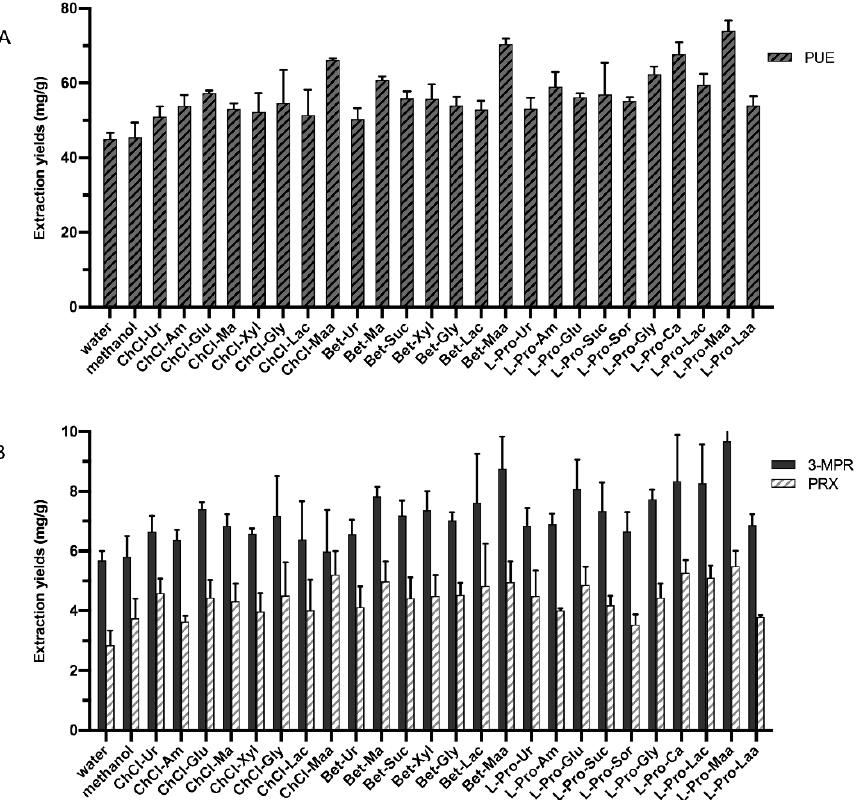
Figure 2. Extraction yields of puerarin (PUE), 3′-methoxypuerarin (3-MPR), and puerarin-6′′-O- xyloside (PRX) from Radix Pueraria (RP) using water, methanol, and 25 different natural deep eutectic solvents (NaDESs). ( A ) Extraction yields of PUE in different solvents; ( B ) Extraction yields of 3-MPR and PRX in different solvents.